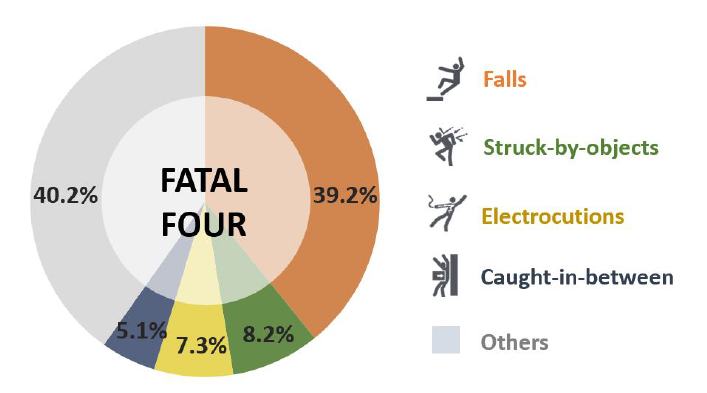
Figure 1. Proportion of accidents attributed to Fatal Four in construction, as reported by the Occupational Safety and Health Administration (OSHA)